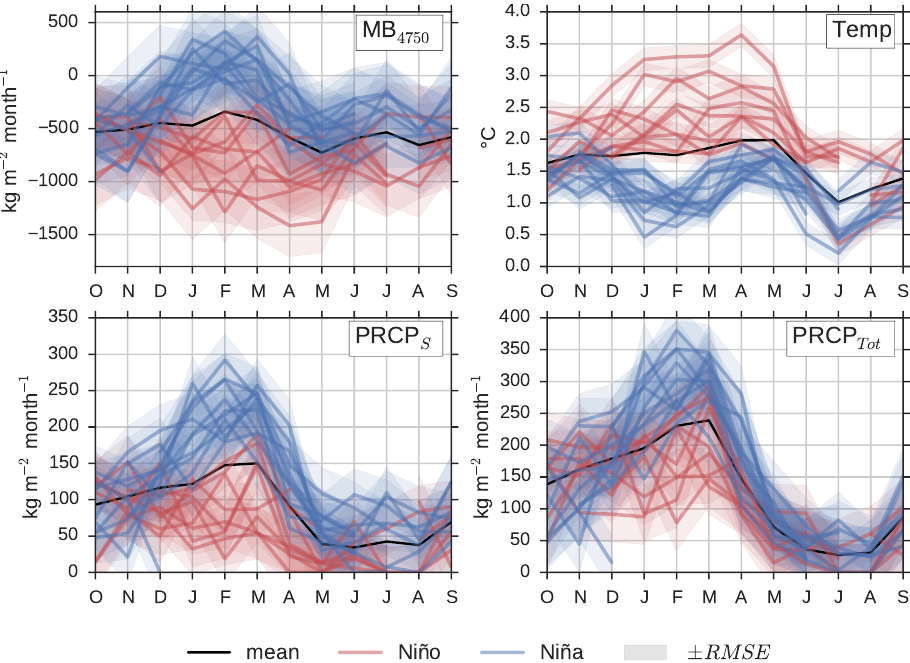
Figure 6. Annual cycles of mass balance, air temperature, solid and total precipitation at 4750ma . s . l . for each Niño (red) and Niña (blue) periods (note that some annual cycles are incomplete). The average of all neutral months is drawn in black (error range omitted for